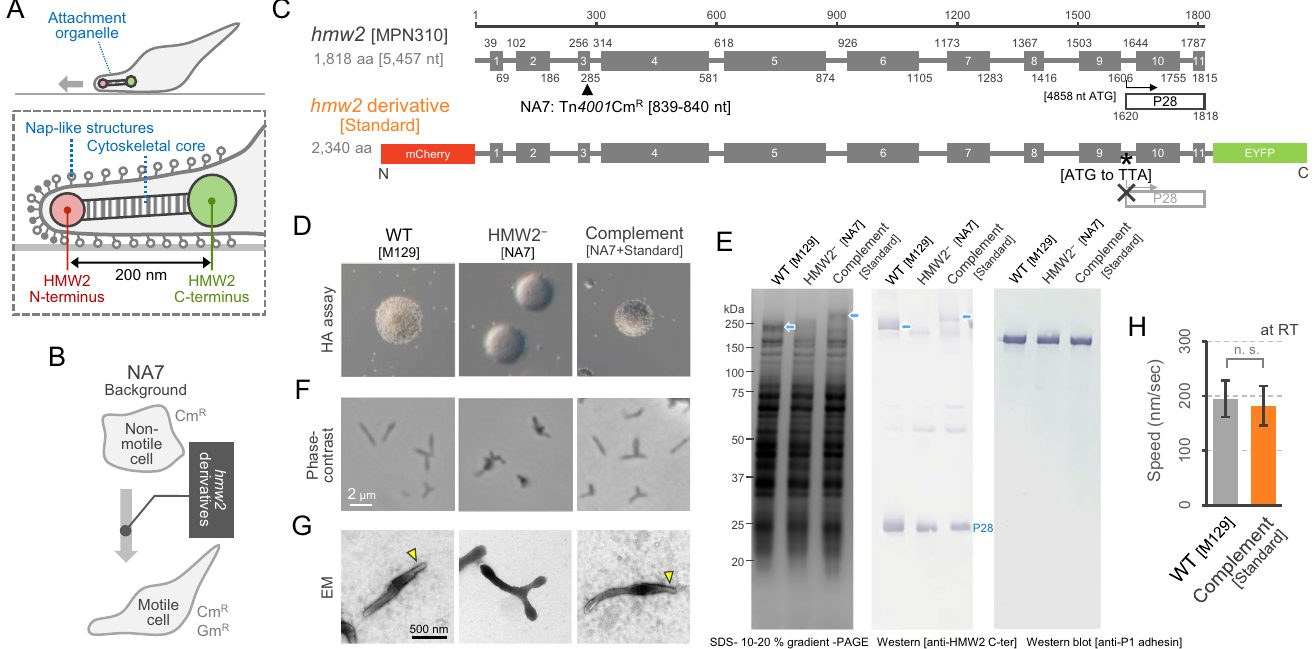
Fig 1. Characterization of an hmw2 -deficient mutant (NA7) and its complementation. (A) Schematics of M . pnenumoniae attachment organelle of. (B) Schematic illustration of the NA7 strain complemented with the hmw2 -derivative gene. (C) Construction of an hmw2 -derivative gene. Top: original hmw2 . Bottom: hmw2 - derivative gene. The gray boxes show 11 domains of the coiled-coil predicted by COILS [41]. The transposon insertion site in the NA7 mutant was indicated by the black triangle. P28 protein derived from internal translation of the hmw2 [18,21]was presented around the 3´ end. The asterisk shows the codon substitution to disturb the internal translation of P28. (D) Hemadsorption assay using sheep blood cells. (E) Protein profiles. Left : Whole cell lysate was subjected to SDS-PAGE, and stained by CBB. Middle and Right : Western blot using antiserum against HMW2 [20] and anti-P1 monoclonal antibody [33] used at the dilutions of 1:1,000 and 1:10,000, respectively. The bands of HMW2 and its derivative was indicated by blue arrows. (F) Cell images under phase-contrast microscopy. (G) Cell images under negative- staining electron microscopy. The attachment organelle was indicated by yellow arrowheads. (H) Speed of gliding motility under phase-contrast microscopy at RT. The average and SD were shown (n = 30). Statistical analysis followed by t -test are shown; n. s. no